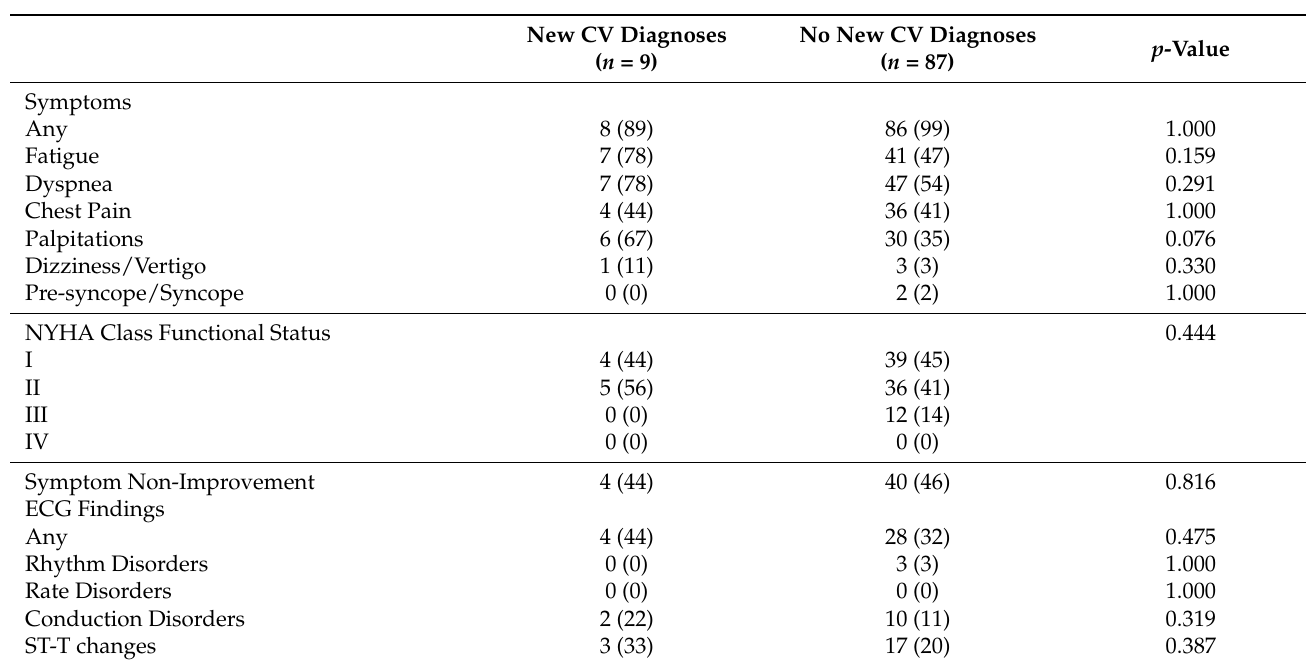
Table 4. Long-COVID symptoms and objective findings according to the presence of a new, presum- ably COVID-related cardiovascular